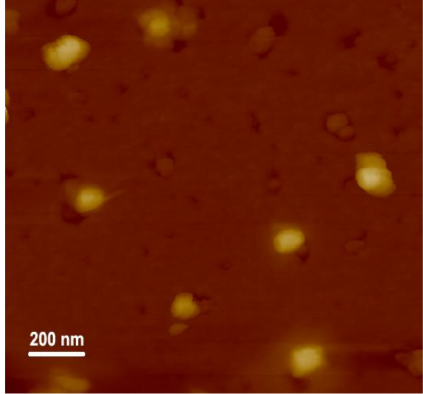
Figure 4. AFM image of DOX-NPs/pDNA complexes at optimal w / w ratio of